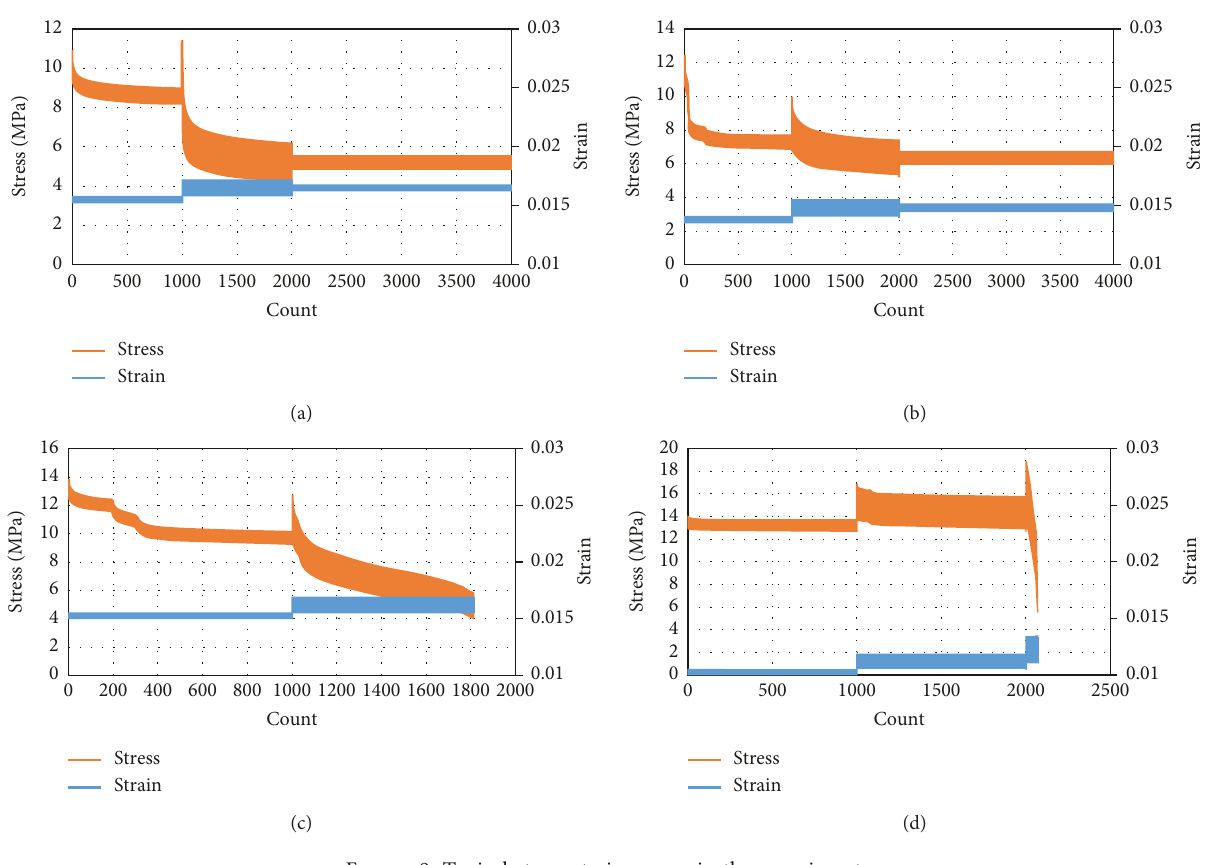
Figure 9: Typical stress-strain curves in the